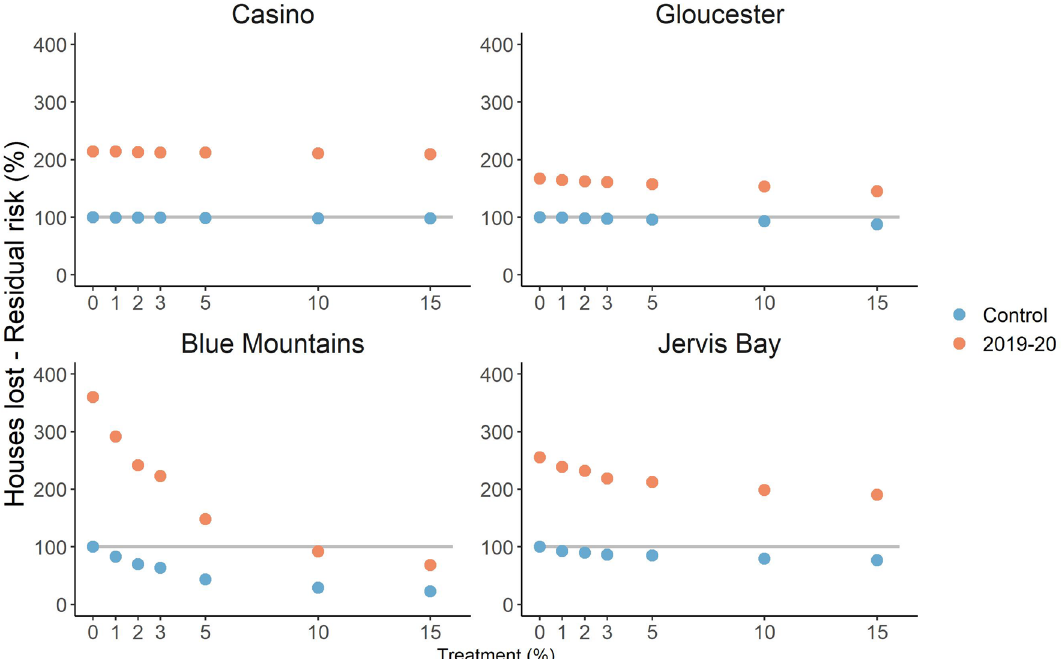
Figure 4.. Residual risk trajectory of houses lost due to wildfire in Casino, Gloucester, Blue Mountains and Jervis Bay. Risk is relative to a scenario with no prescribed burning and long-term weather (the 100% level on the y-axis). Markers represent different annual rates of treatment, colours represent different weather conditions (blue = control i.e. long-term, orange = 2019–2020 fire